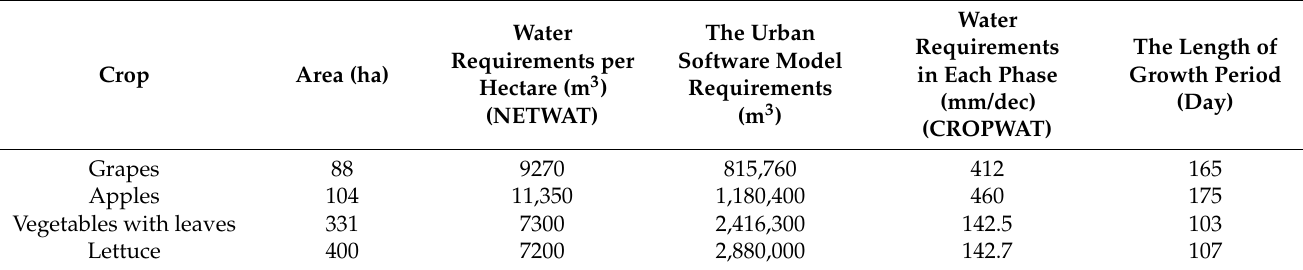
Table 4. An analysis of the water requirements for plants using the NETWAT & CROPWAT ap- proaches in the software model of